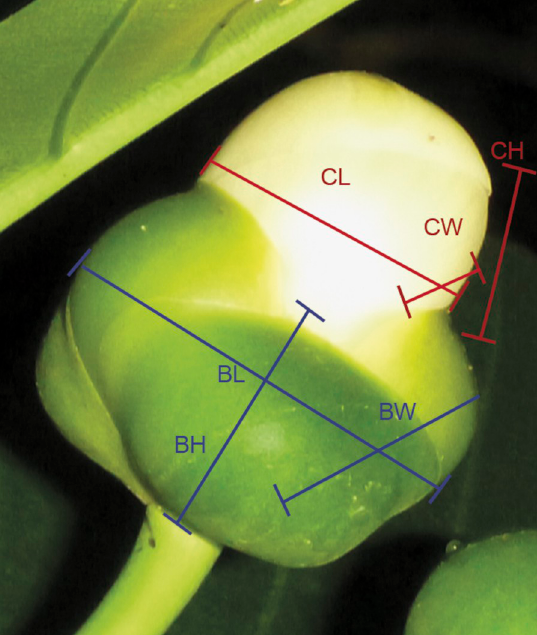
Fig 1. Measurements of mature flowers. Corolla height (CH), corolla width (CW), corolla length (CL), calyx height (BH), calyx width (BW), and calyx length